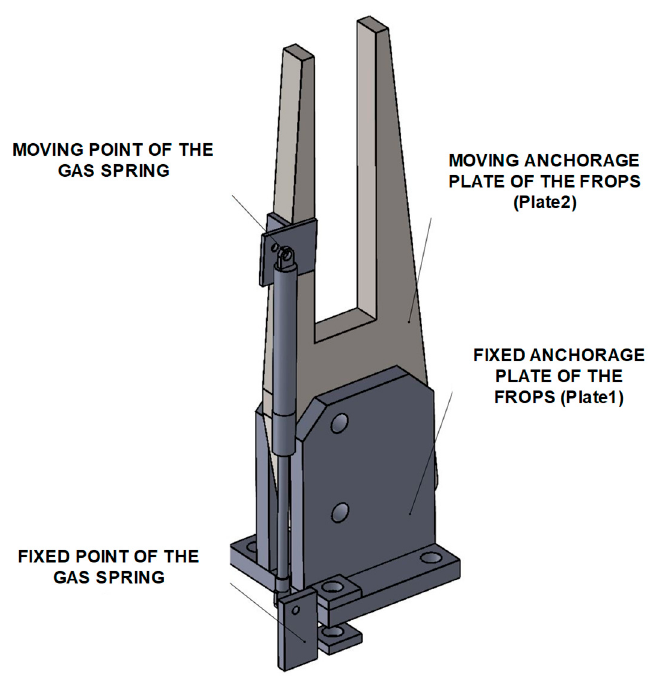
Figure 10. Details of the gas-spring assembling points.